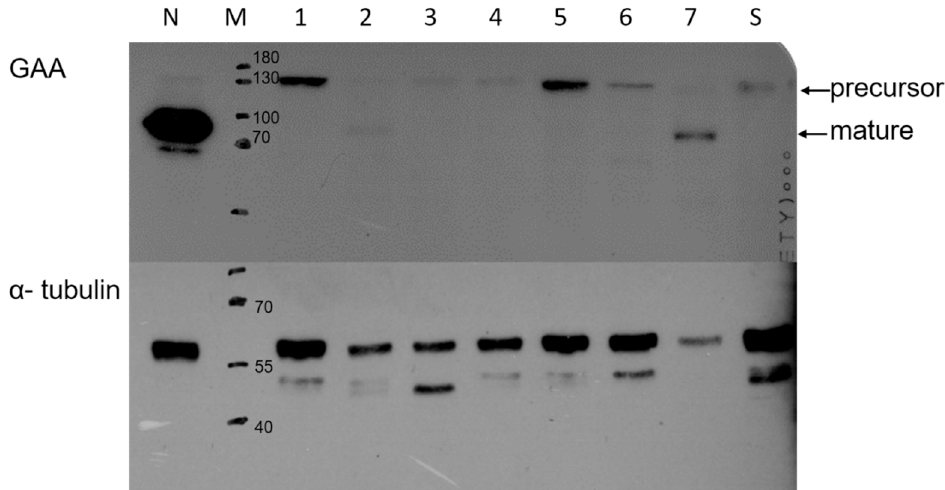
Figure 2. Blood glucosidase alpha acid (GAA) Western Blotting of this case (S), indicating a cross-reactive immunologic material (CRIM)-positive status. The lymphocytes were sonicated and then blotted with antibodies to detect human GAA and α -tubulin protein presence. M: marker; N: normal newborn; No. 1 and No. 3 were from infantile-onset Pompe disease (IOPD) patients with the CRIM(+) GAA variant; No. 2, No. 4–7 were from newborns with low GAA activity. N: normal control sample; M: marker. Precursor: 110kDa GAA. Mature: 70/76 kDa GAA.